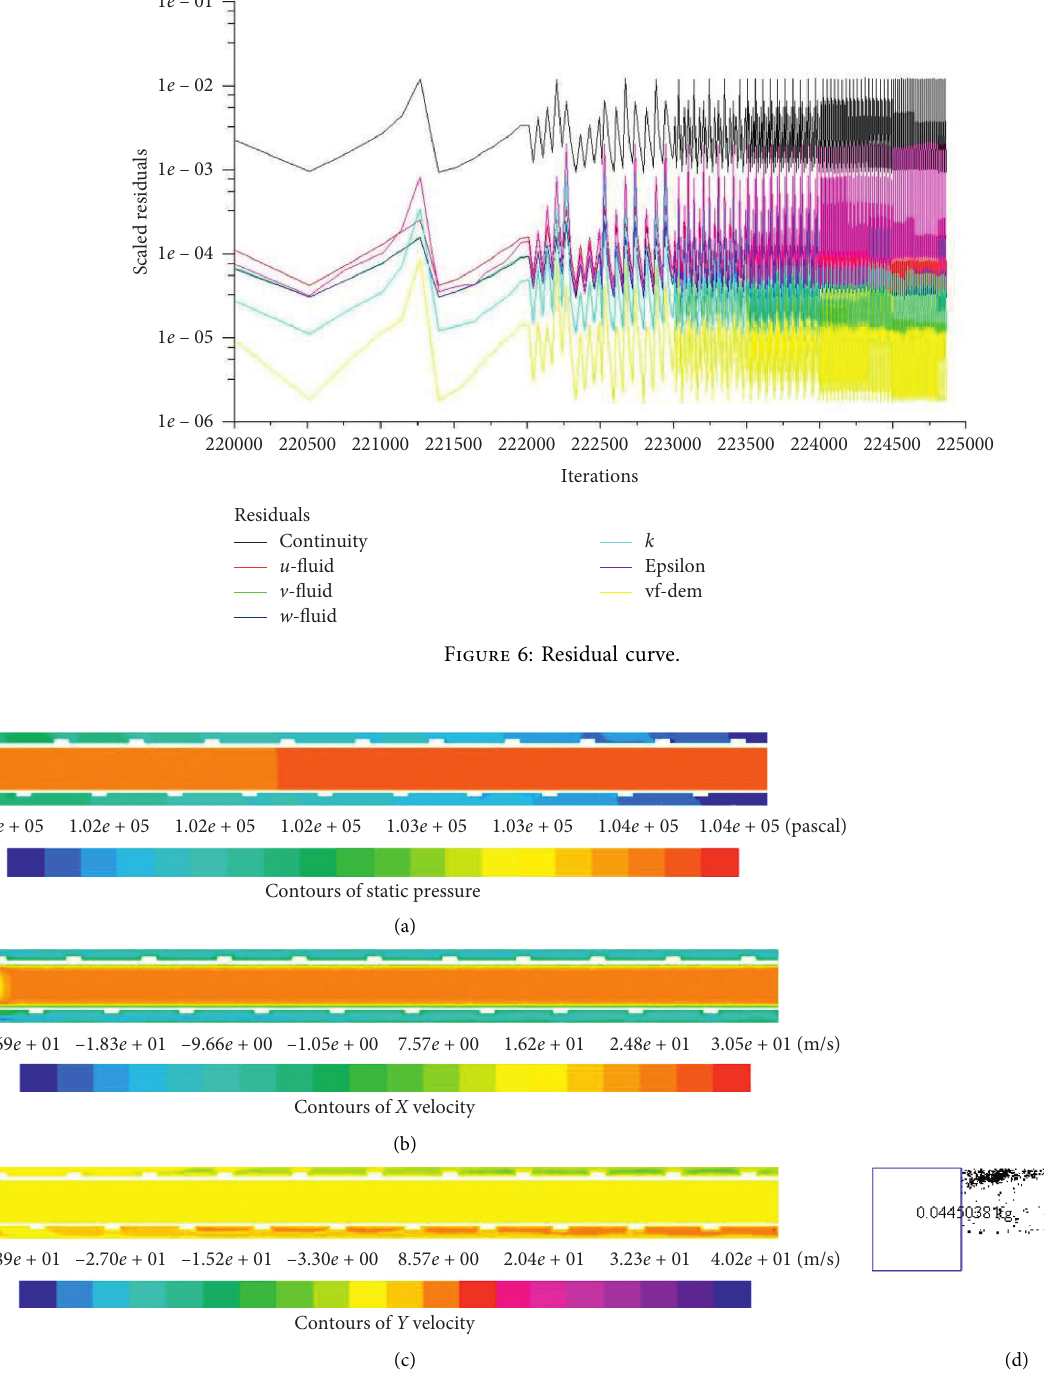
Figure 7: Simulation results of original drill pipe. (a) Nephogram of static pressure distribution for airflow migration. (b) Distribution nephogram of X direction velocity of flow. (c) Distribution nephogram of Y direction velocity of flow. (d) Mass of discharge